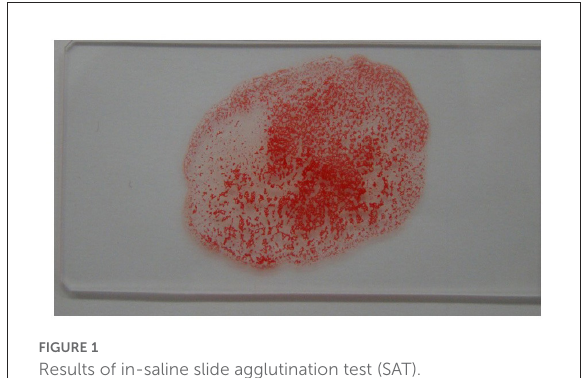
FIGURE1 Results of in-saline slide agglutination test (SAT). Self-agglutination was positive.